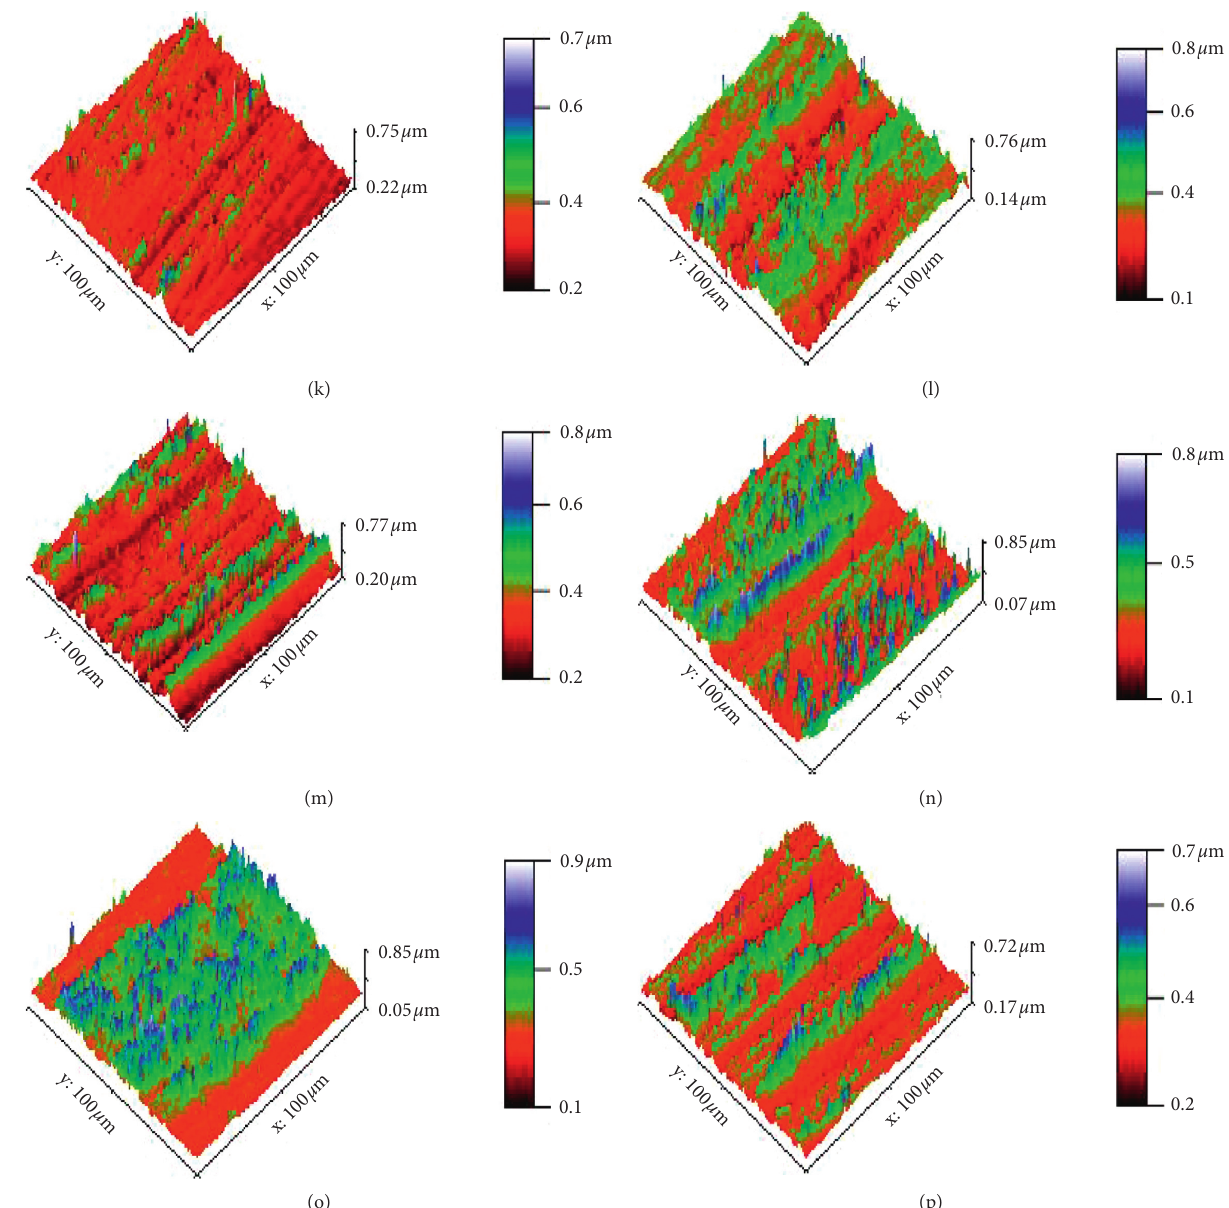
Figure 10: 3D Profilometric images: (a) (S-1). (b) (S-2). (c) (S-3). (d) (S-4). (e) (S-5). (f) (S-6). (g) (S-7). (h) (S-8). (i) (S-9). (j) (S-10). (k) (S- 11). (l) (S-12). (m) (S-13). (n) (S-14). (o) (S-15). (p) (S-16).